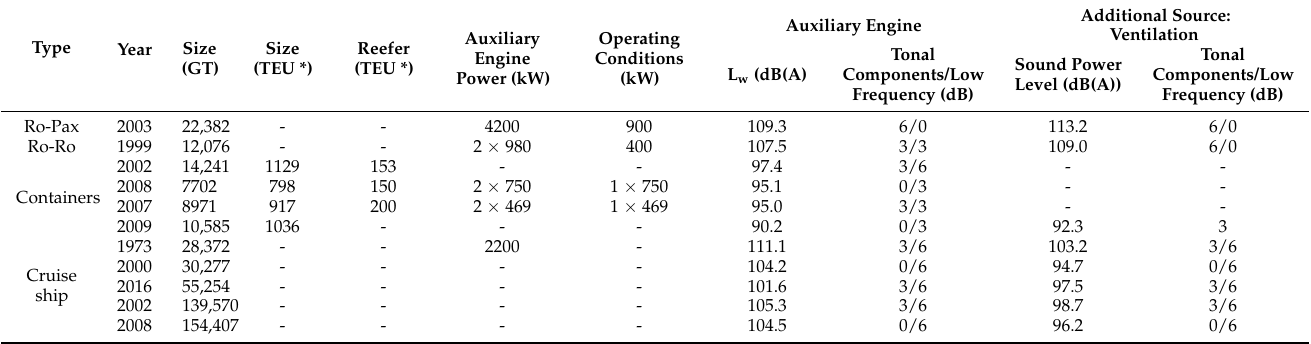
Table 7. Noise emission data of moored ship, as reported in [27]. * TEU: twenty-foot equivalent